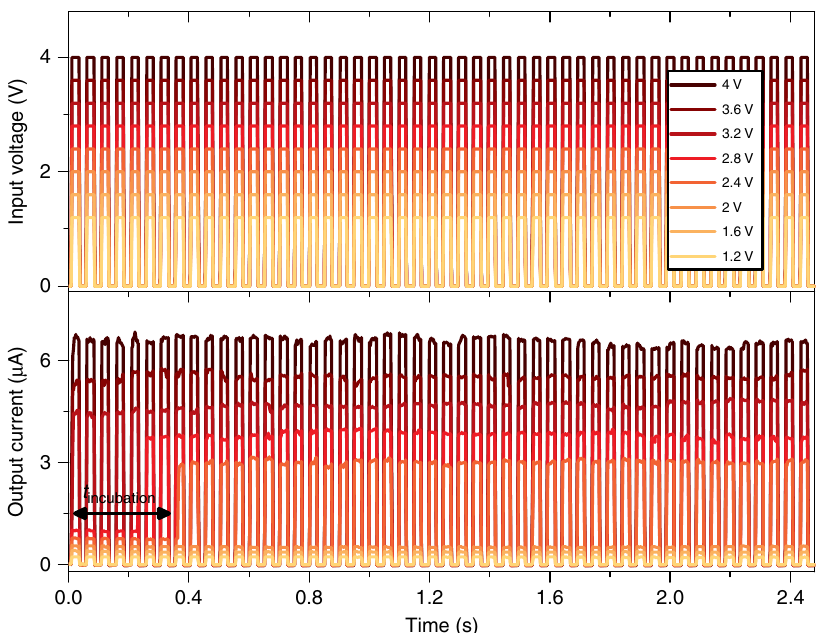
Fig. 6 Single NW device response to an input train of electrical pulses. The higher panel shows the input voltage pulse trains composed of 50 pulses of 22 ms length (22 ms of waiting time) for different voltage amplitudes (from 1.2 to 4 V). The current responses of the device are presented in the lower panel, showing current jumps for voltage amplitudes ≥ 2.4 V. The number of pulses needed for inducing a switching event (i.e. the incubation time) decreases by increasing the pulse amplitude. The incubation time observed by stimulating the device with a pulse train of 2.4 V amplitude is indicated by the